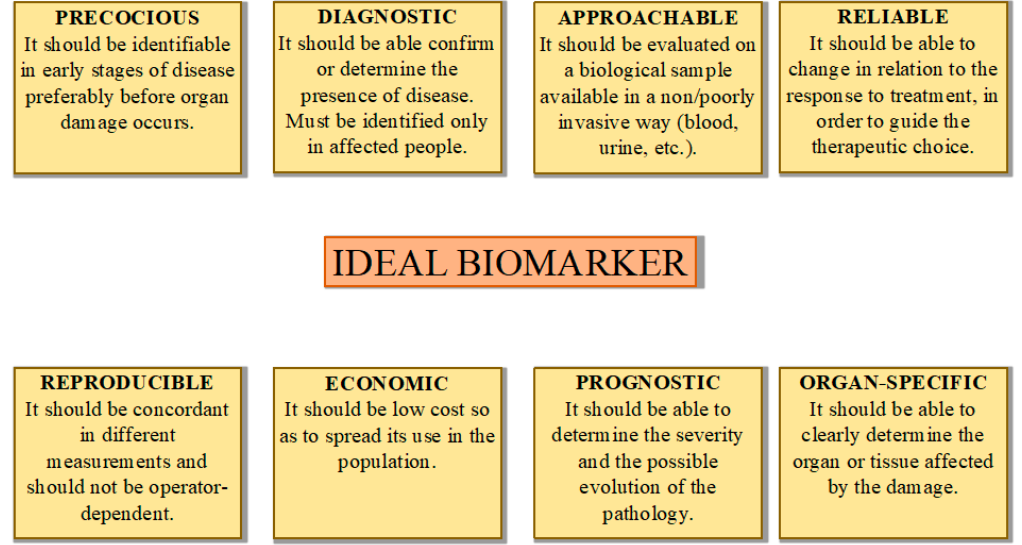
Figure 1. Ideal characteristics of a biomarker in the diagnosis and monitoring of a disease.